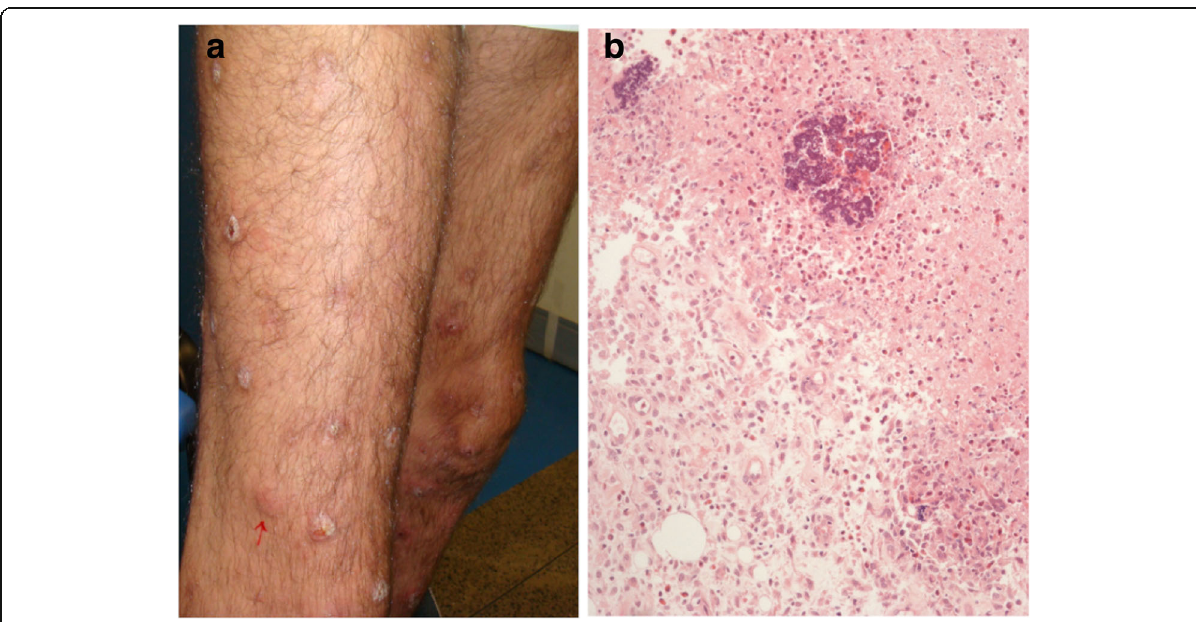
Fig. 9 Septic panniculitis in HIV positive male, caused by hematogenous dissemination. a Erythematous papules and ulcerated nodules on the lower limbs. b Basophilic areas corresponding to masses of microorganisms, with necrosis and infiltrate composed of neutrophils, eosinophils and histiocytes in the hypodermis. H&E,